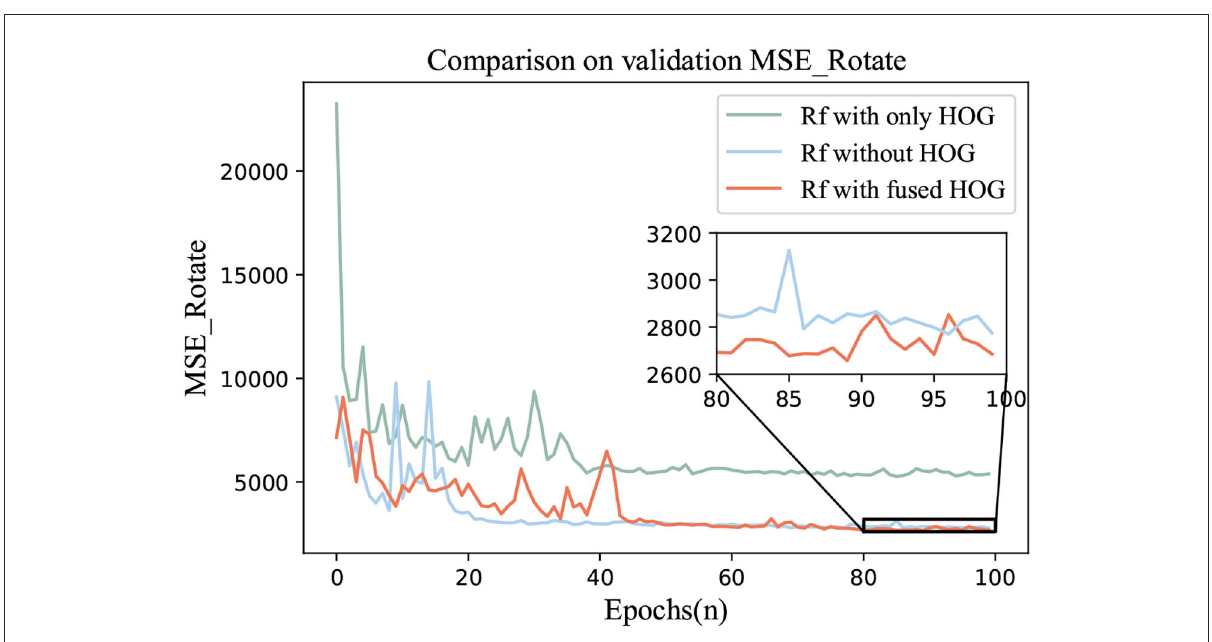
FIGURE9 Comparison of MSE_Rotate values in ablation experiment.